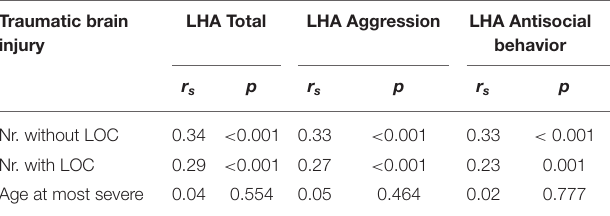
TABLE 3 | Correlations (Spearman’s rho) between number of traumatic brain injuries, age at most severe traumatic brain injury, and the Life History of Aggression